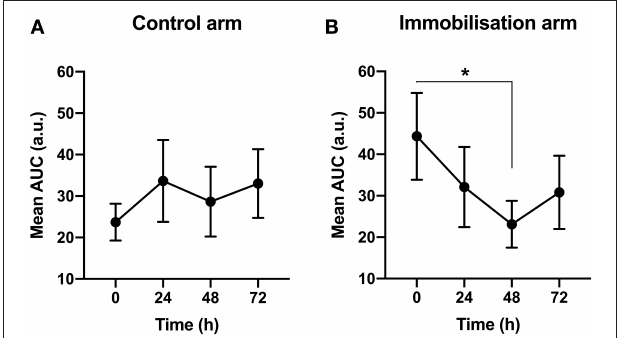
FIGURE 3 | The effect of immobilization on motor excitability. (A) In the control arm, there was no significant change in motor excitability across time. (B) In the immobilized arm, there was a reduction in motor excitability across time ( p < 0.05). *0 vs. 48h ( − 48%) ( p <